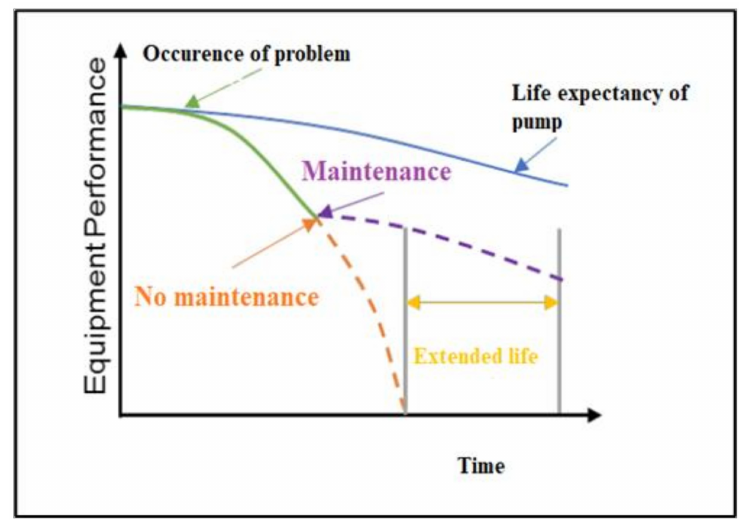
Figure 2. Predictive maintenance extending the equipment’s lifespan